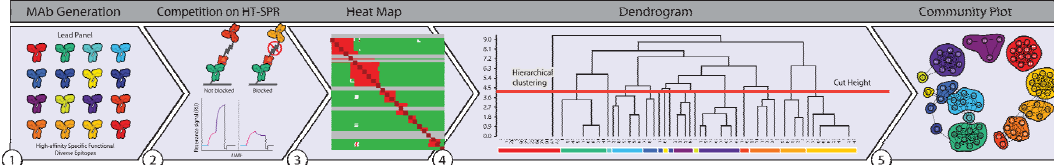
Figure 2. Schematic overview of experimental epitope binning, identifying cross-competition between Abs for binding an Ag. Sensorgrams are assessed for blocking, inferring whether or not two Abs block each other from binding in a competition assay and thus are assumed to bind the same epitopic region on the Ag. The blocking data is collected in a heatmap that indicates whether or not each Ab pair blocks (red blocked, green sandwiched). The heatmap is processed with hierarchal clustering algorithms based on similarity in blocking profiles, thereby generating a dendrogram. Finally, cutting the dendrogram separates Abs into clusters represented in a community network, which has nodes for the Abs and edges indicating which pairs block each other.